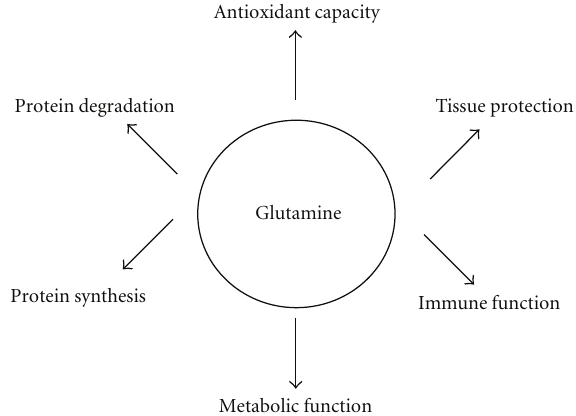
Figure 1: Schematic representation of the mechanism of glutamine